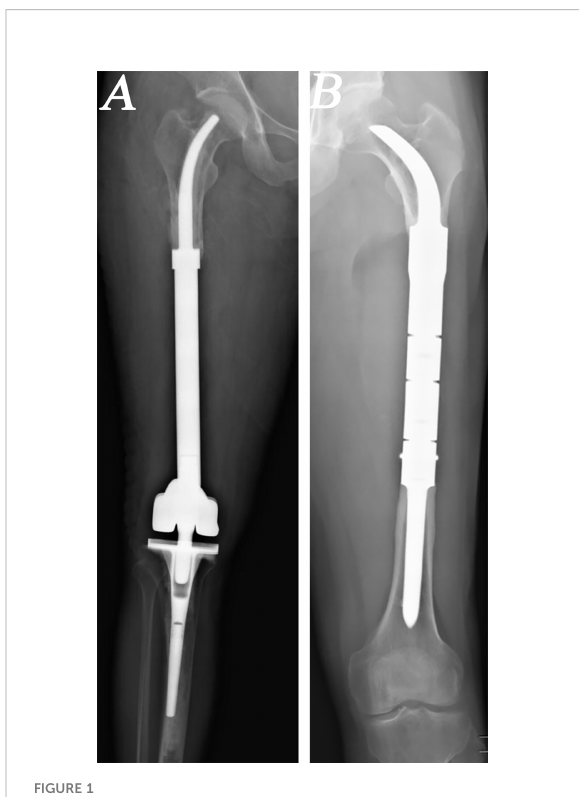
FIGURE 1 Radiographs of patients who underwent hip-preserving reconstruction (HPR) with intra-neck curved stem (INCS). (A) A patient who underwent HPR with cemented INCS. (B) A patient who underwent HPR with cementless INCS. (HPR: hip- preserving reconstruction; INCS: intra-neck curved